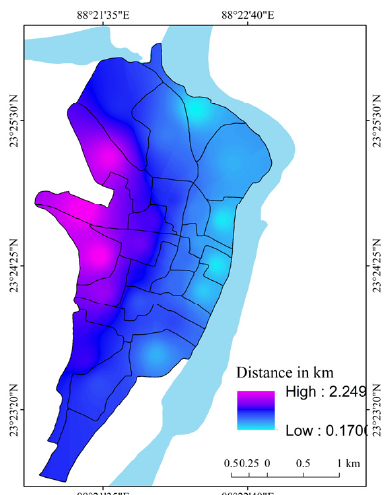
Figure 26. Distance of the centers of the municipal wards from the old river course (2000).